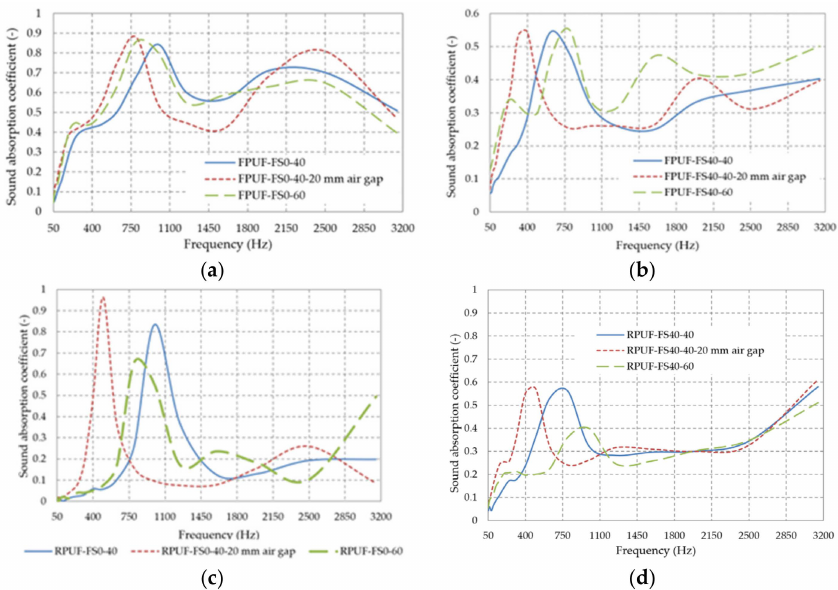
Figure 6. Sound absorption coefficient variation with: ( a ) thickness and position of flexible polyurethane foam samples, ( b ) thickness and position of flexible polyurethane foam samples with 40% fir sawdust, ( c ) thickness and position of rigid polyurethane foam plates, and ( d ) thickness and position of rigid polyurethane foam samples with 40% fir